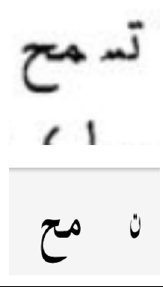
Figure 28: Example of poor scan quality—missing print in